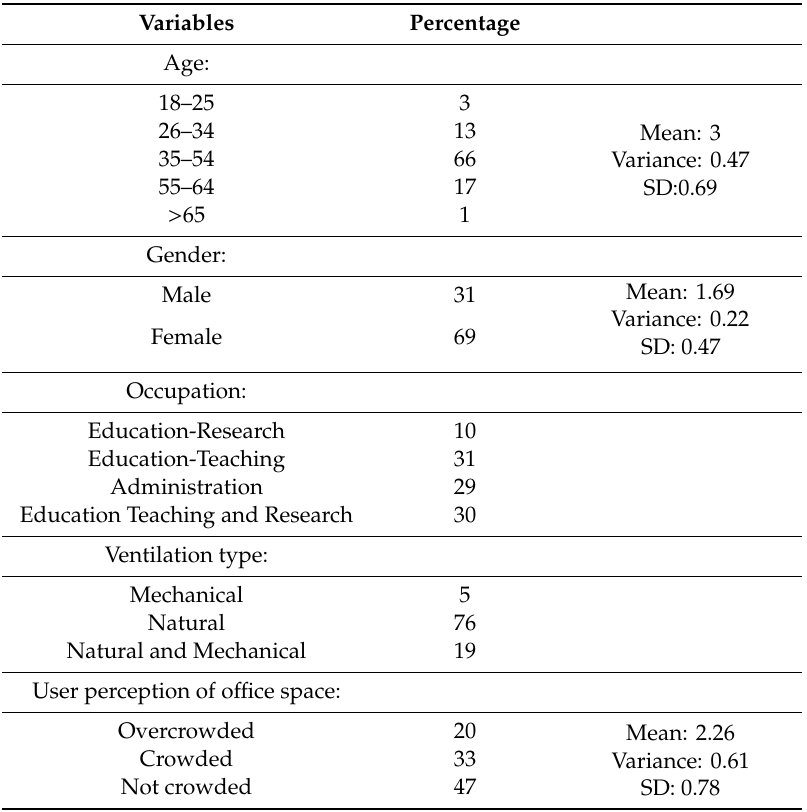
Table 1. Characteristics of the survey participants.